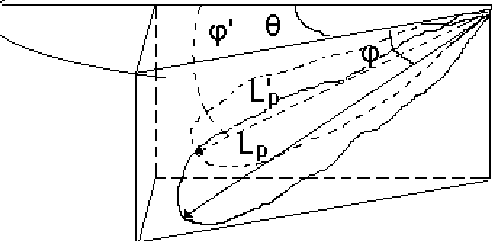
Figure 6. Representation of spray, with marked tip penetration length and angles of spray centreline.